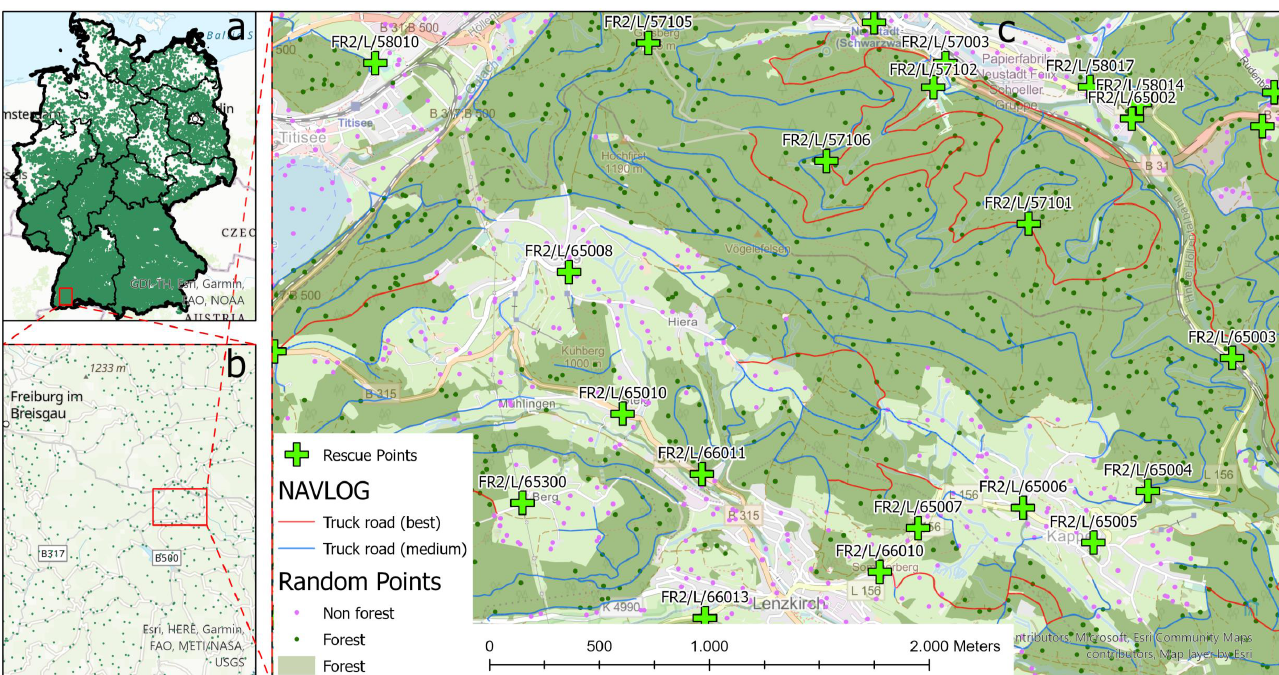
Figure 3. ( a ) Spatial distribution of rescue points (n = 63,718) in Germany. ( b ) Regional example map of the spatial distribution of rescue points in relation to forest and forest roads. ( c ) Local example map of the spatial distribution of rescue points (green crosses) in relation to forest (dark green) and forest roads (red/blue lines). Illustration of random sample points (10,000,000 for Germany) inside (green points) and outside (purple points) the